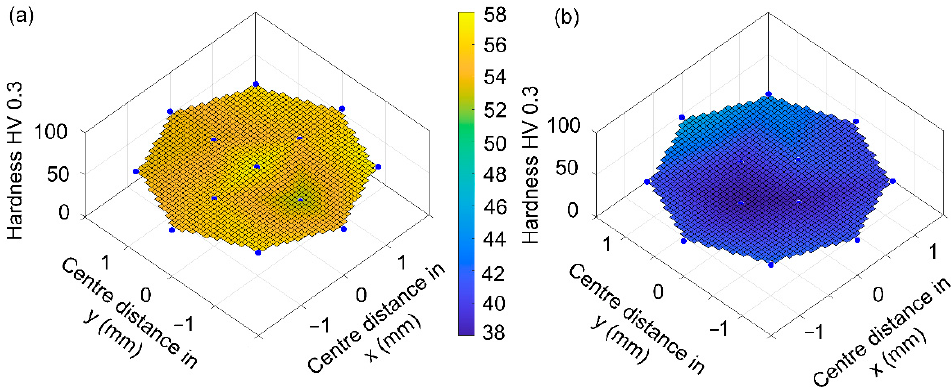
Figure 6. Hardness distribution over the cross-sectional area of ( a ) EN-AW-6060 wire extruded with a rotational speed of 6 rpm, ( b ) EN-AW-6060 reference specimen. a rotational speed of 6 rpm, ( b ) EN-AW-6060 reference